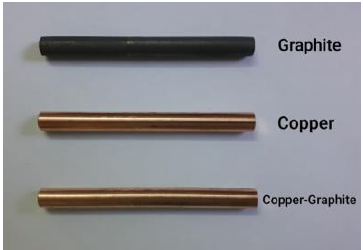
Fig. 2. Tool electrode